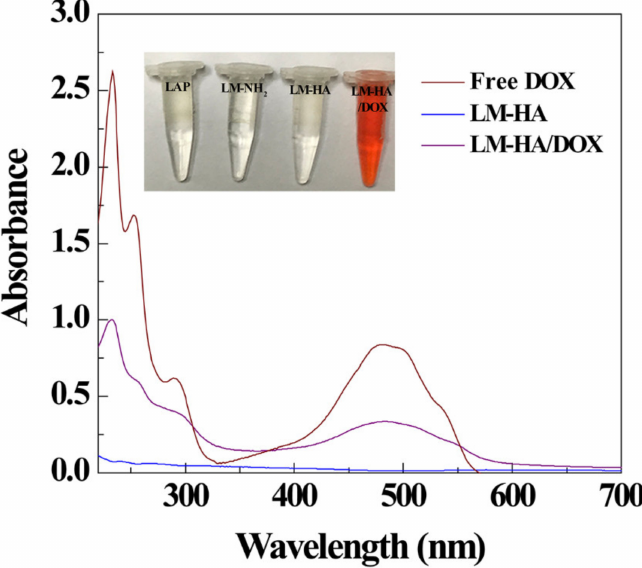
Figure 4. UV-vis spectra of free doxorubicin (DOX), LM-HA, and LM-HA/DOX,